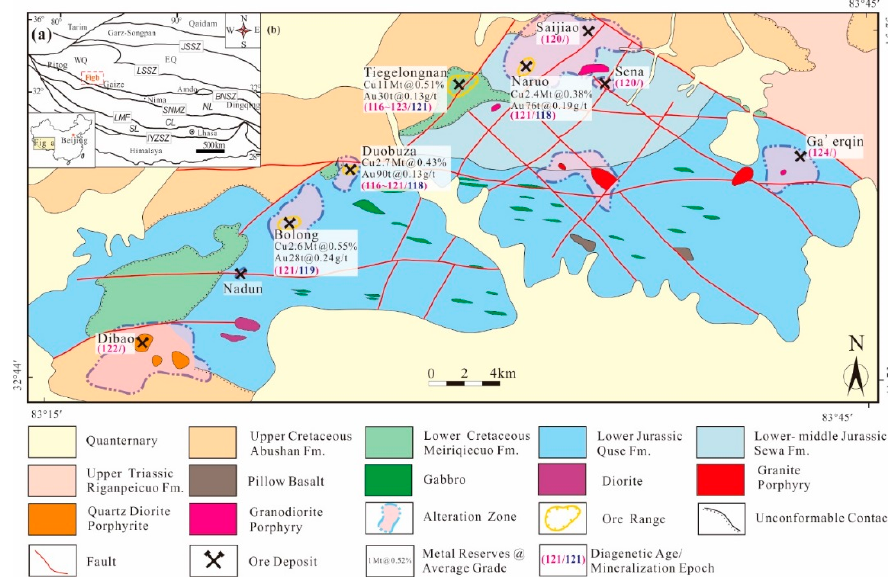
Figure 1 . Regional geological map of the Duolong ore cluster, modified after [8], ages are from